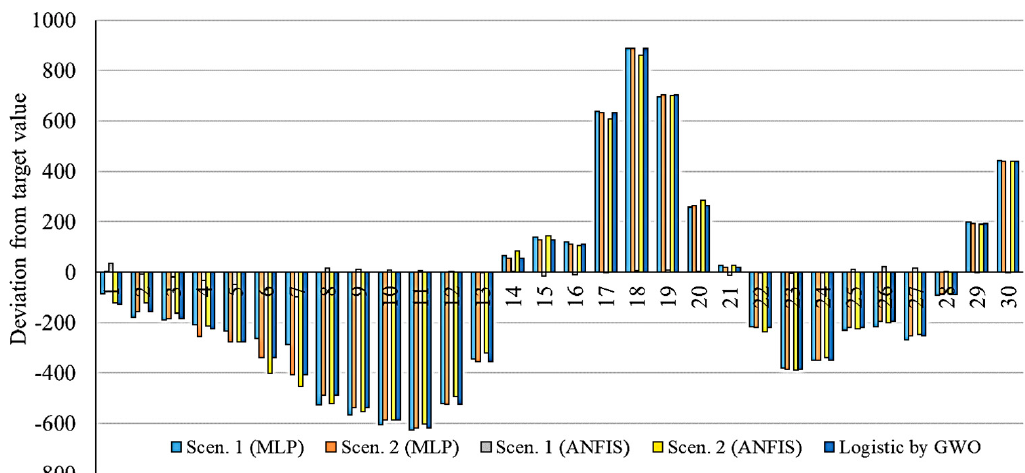
Figure 19. Deviation from target value for models related to Iran.